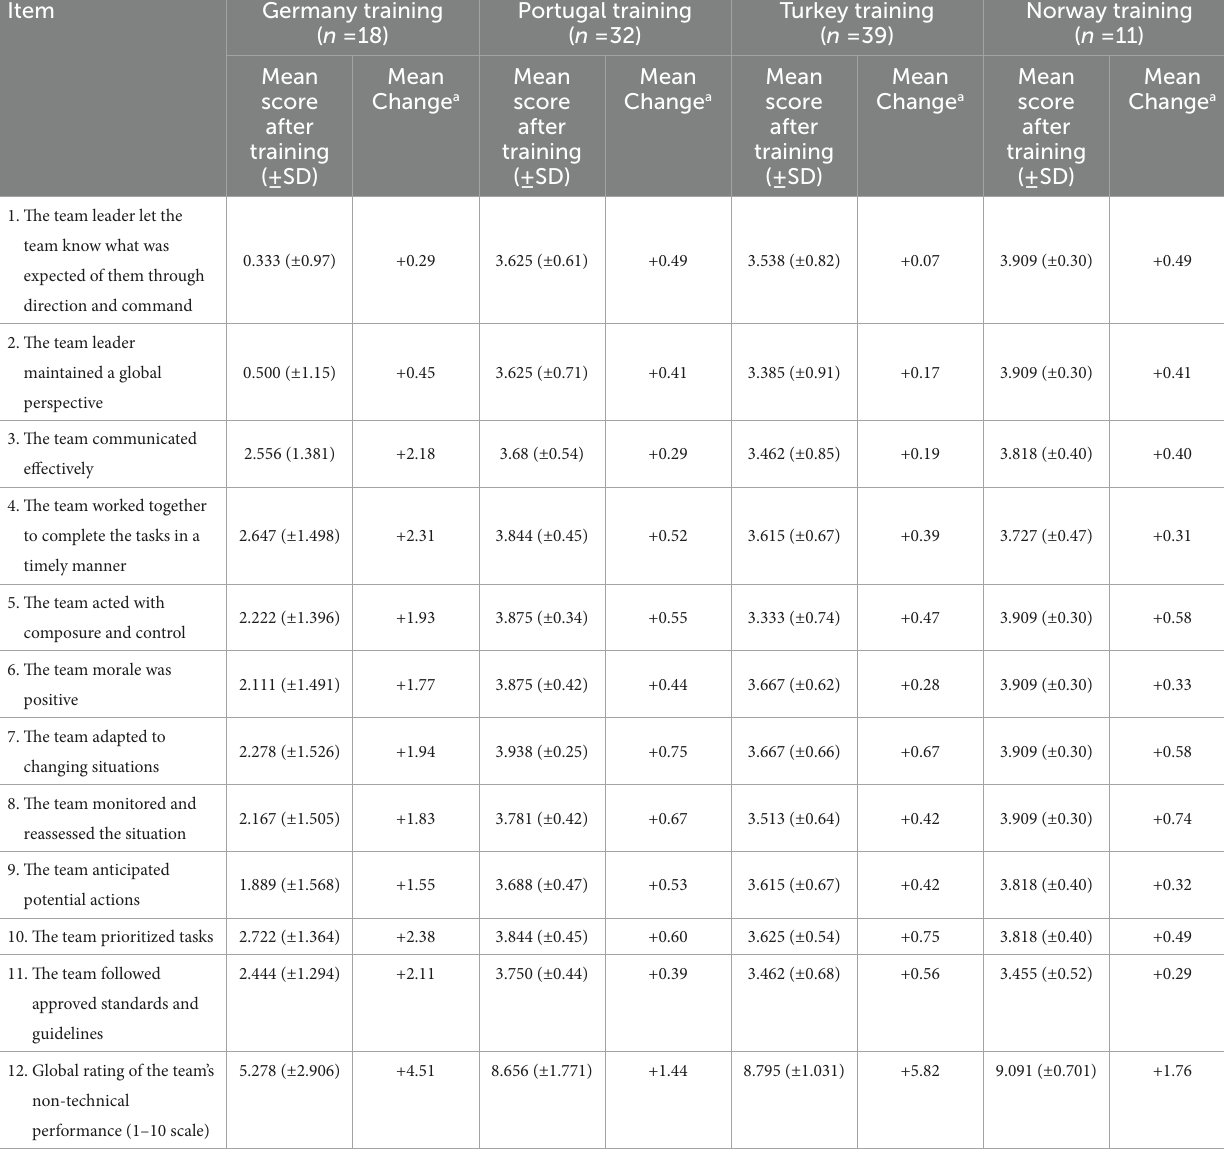
TABLE 5 Comparison of means, and their change per item of the Teamwork scale between countries ( N =